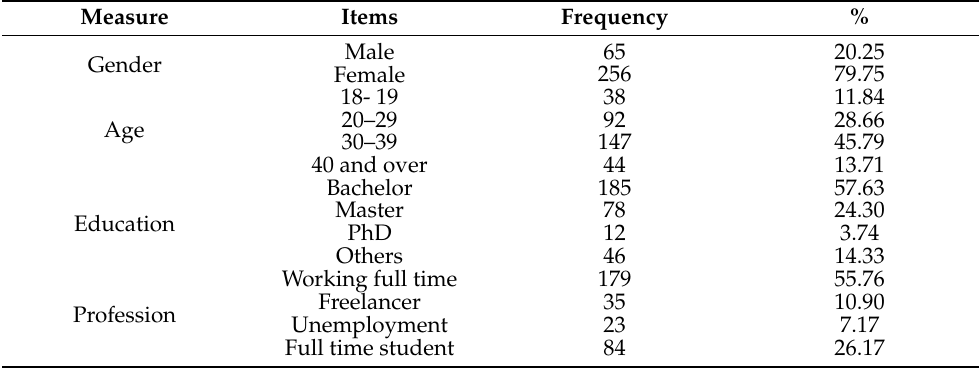
Table 2. Profile of the